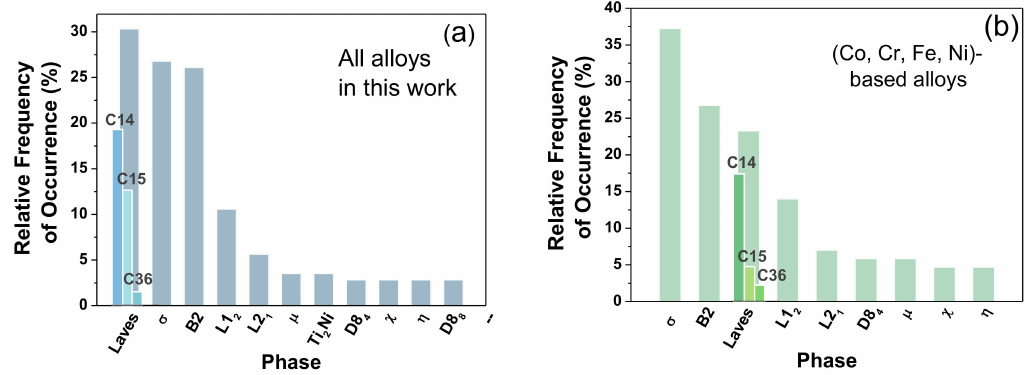
Figure 2. Relative frequencies of occurrence for the most common IM structures in this study: ( a ) Based on all alloys in the database; ( b ) Based on (Co, Cr, Fe, Ni)-based alloys